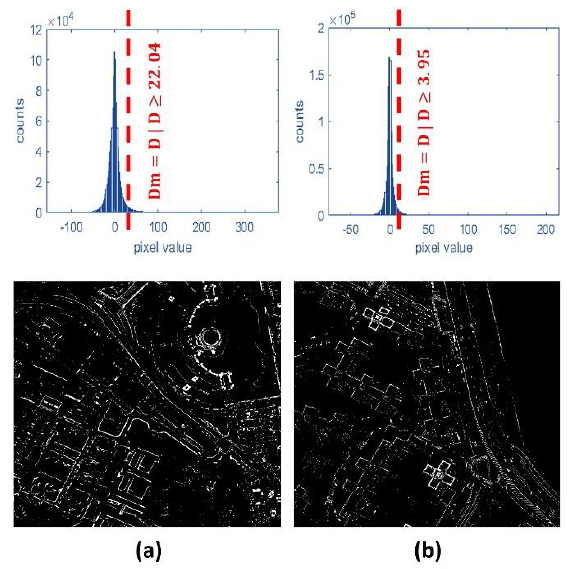
Figure 9. The results of MLT and the produced D m : (a) San Francisco dataset, (b) NY